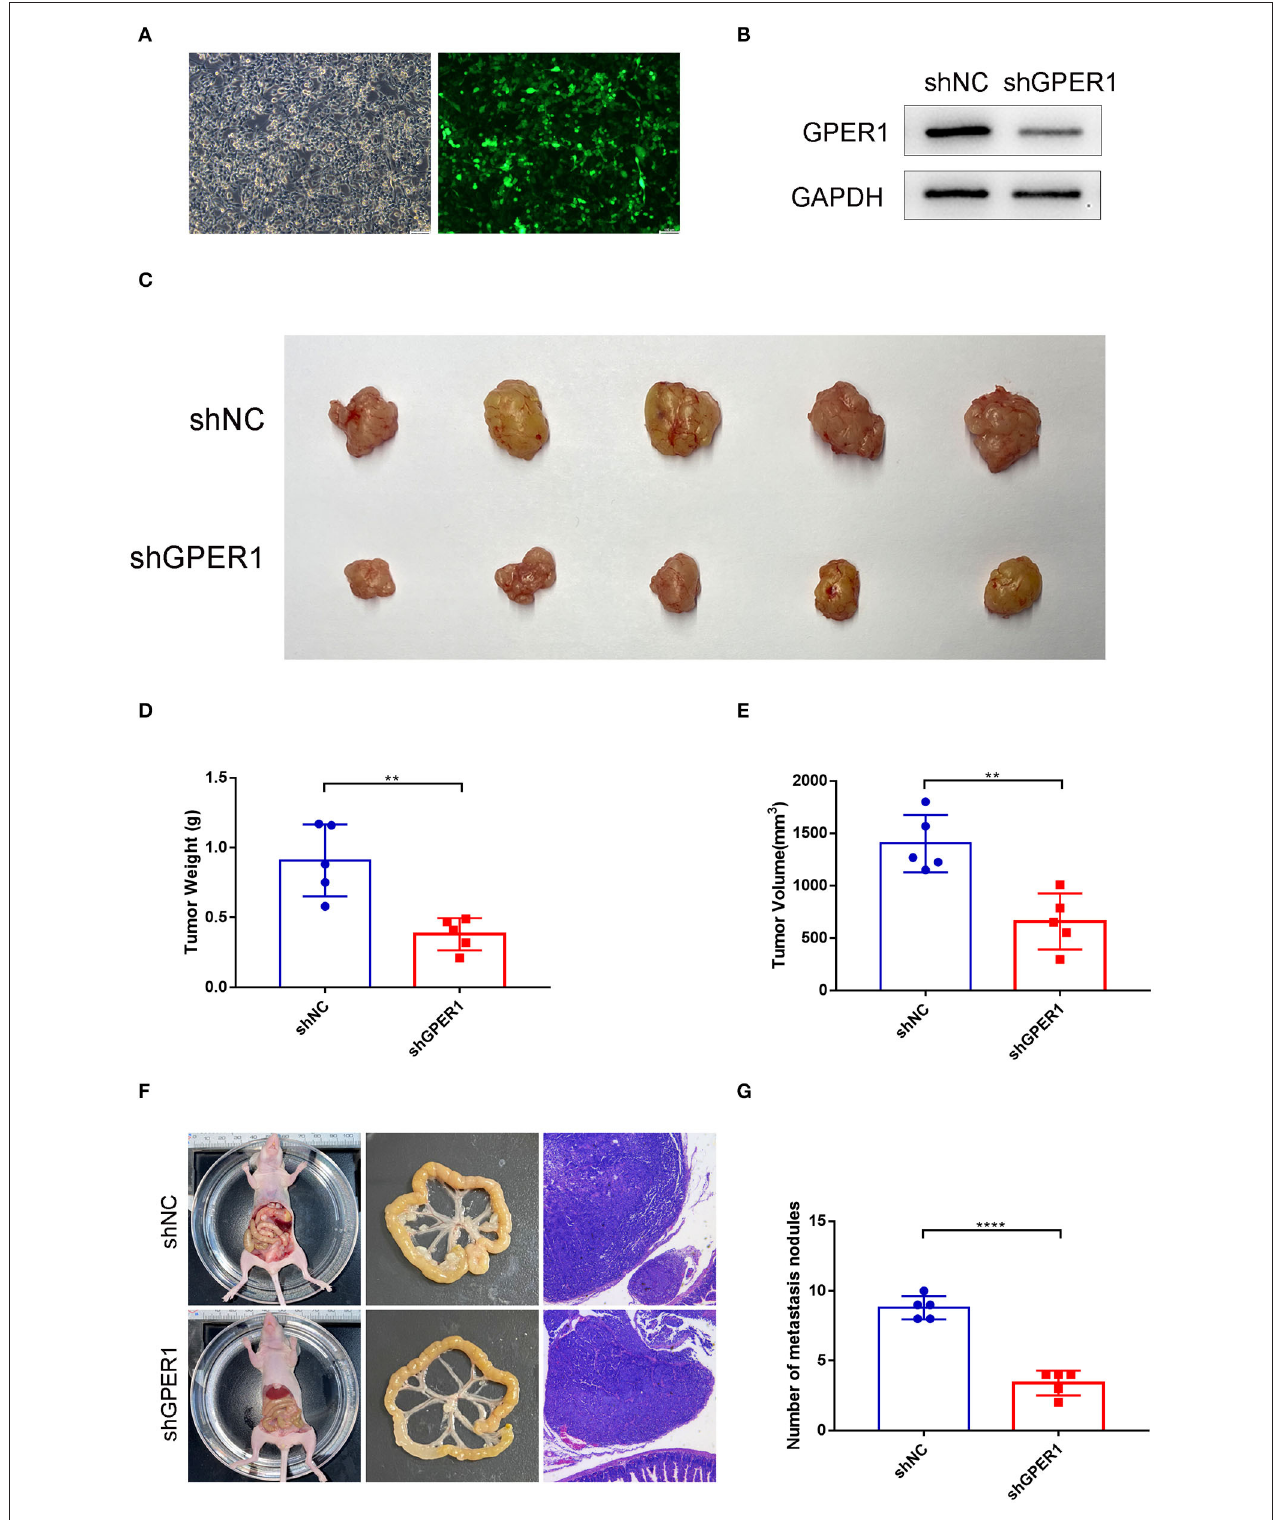
FIGURE 7 | GPER1 knockdown inhibited tumor growth and peritoneal dissemination in vivo . (A) Fluorescence was used to verify the infection efficiency (magnification × 200); (B) Western blot analysis of knockdown efficiency of shGPER1; (C) Image of tumors of mice in shGPER1 and shNC groups; (D) Volume of tumor of mice in in shGPER1 and shNC groups; (E) Weight of tumor of mice in shGPER1 and shNC groups; (F) Representative intestines and H&E staining of scattered tumors in nude mice; (G) The quantification of metastases in nude mice was counted. ** P < 0.01; **** P < 0.0001.